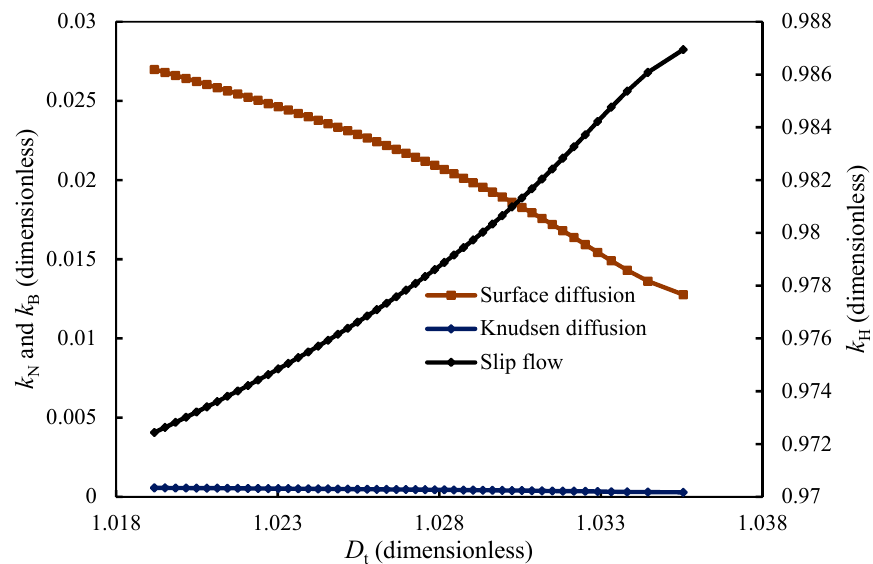
Figure 9. Relationship between contribution rate and fractal dimension of